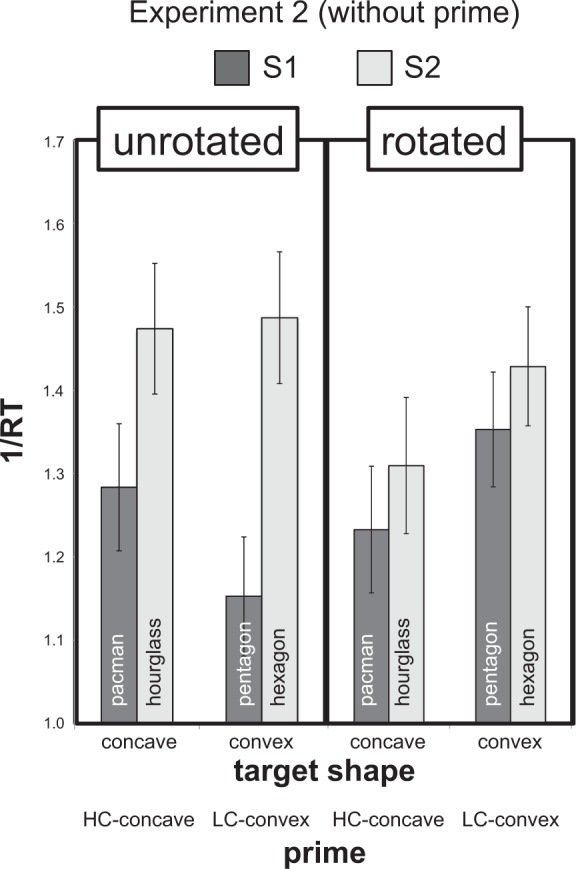
Experiment 2. Mean values of 1/RT (± 1 sem) in the within-subjects
Rotation × CCP × Symmetry design.